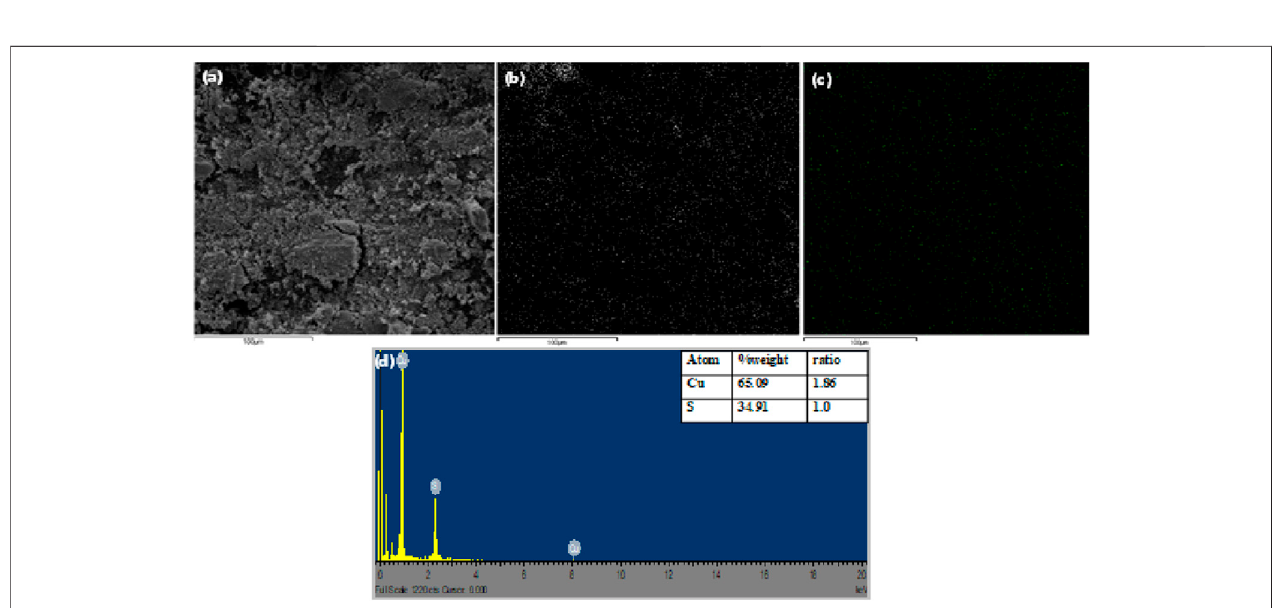
FIGURE 3 | (A) SEM image of Cu 9 S 5 (B,C) elemental mapping of Cu and S respectively, and (D) EDX spectra of Cu 9 S 5 .